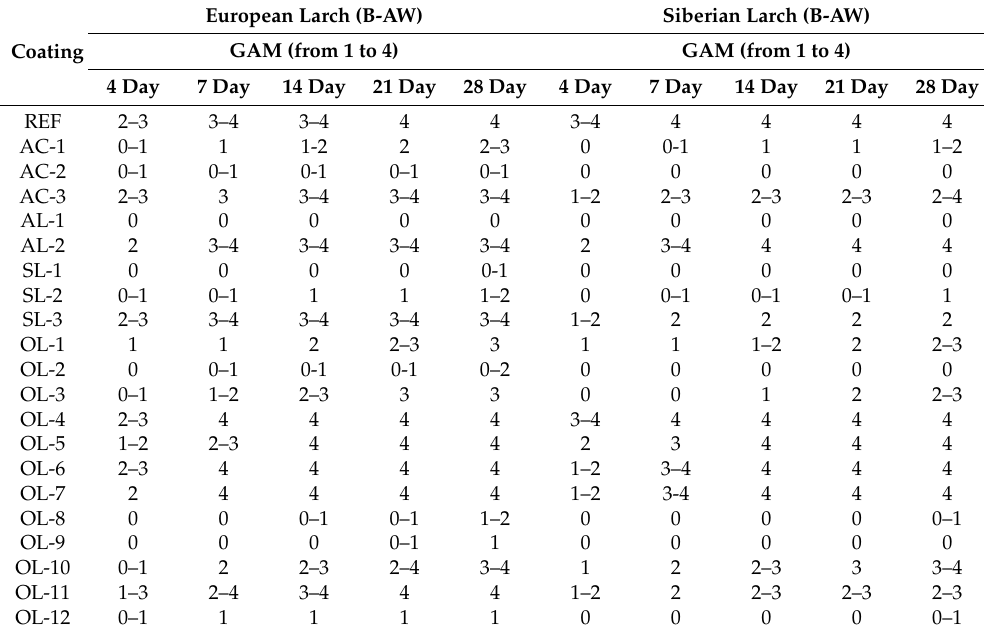
Table 4. Growth activity of moulds (GAM) on surfaces of larch samples treated with commercial coatings before artificial weathering (B-AW).